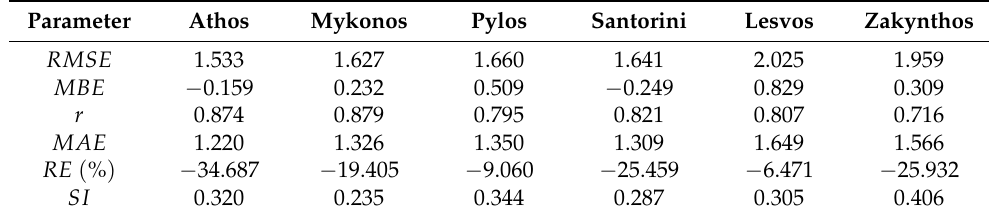
Table 4. Results of data evaluation of the wind speed u W obtained from ERA5 and in-situ measurements. Parameter Athos Mykonos Pylos